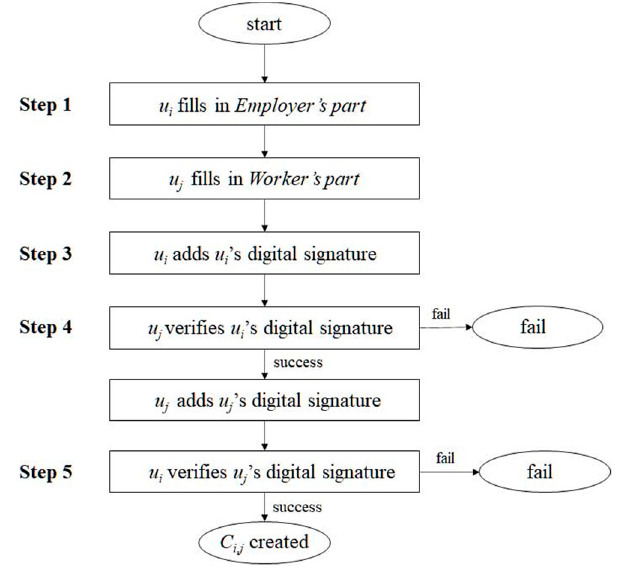
Figure 2. Contract creation